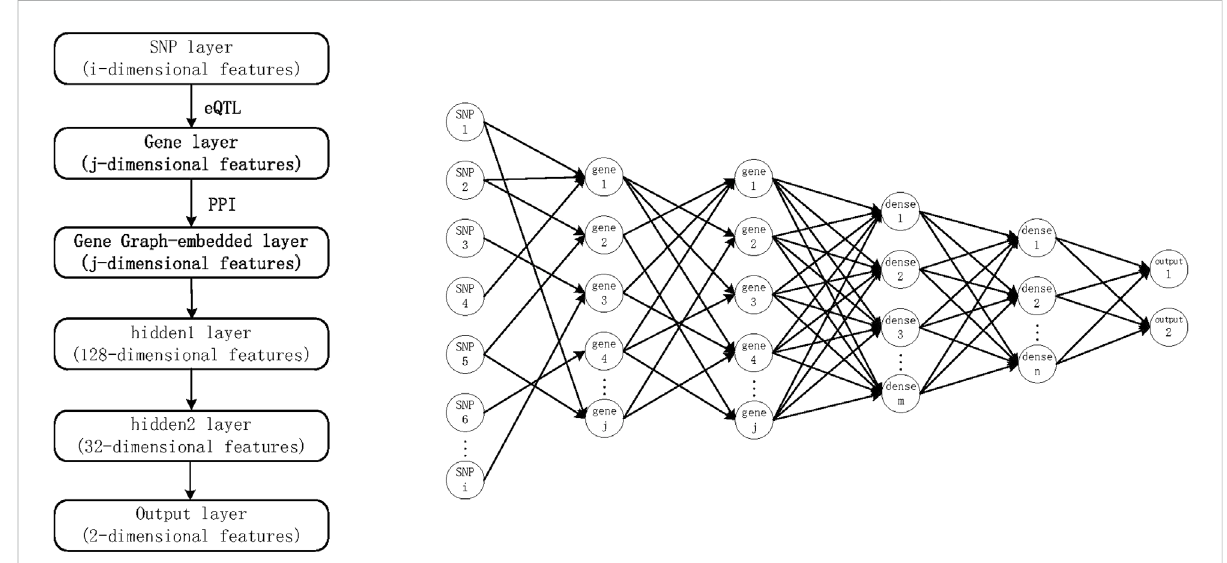
FIGURE 1 G-EDNN model diagram based on expression quantitative trait loci data. The intergenic correlation network is embedded into a DNN to form the fi nal G-EDNN